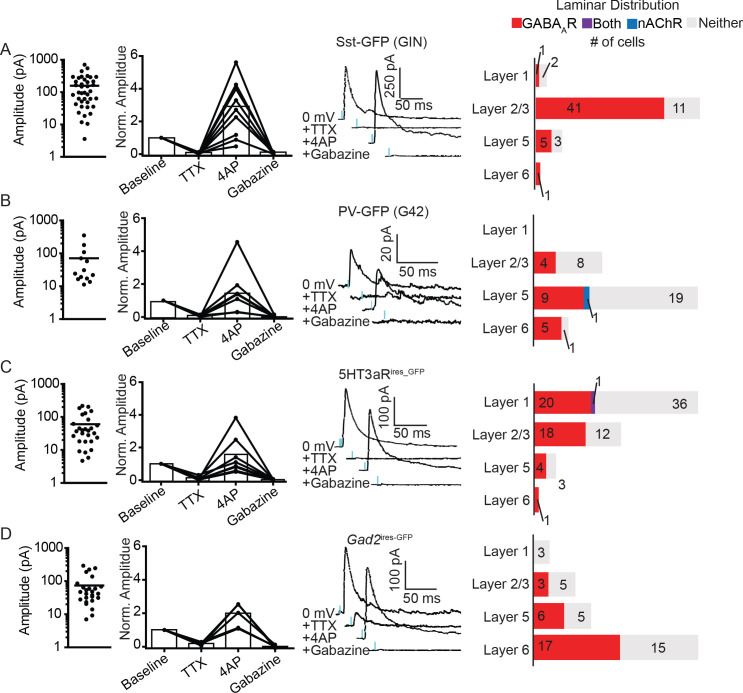
GABAAR-mediated synaptic currents from VIP+/ChAT+ interneurons are mono-synaptic.(A–D). Synaptic response amplitudes, sensitivity to TTX, 4AP, and gabazine, and laminar distribution for GFP-expressing post-synaptic neurons in Sst-GFP (GIN) mice (A), PV-GFP (G42) mice (B), 5HT3aRires-GFP mice (C), and Gad2ires-GFP mice (D). Left: mean response amplitude. Middle left: Quantification of sensitivity to TTX, 4AP, and gabazine. All synaptic responses are blocked by TTX, substantially rescued by 4AP, and completely abolished by gabazine. Middle right: example traces showing synaptic response amplitude following consecutive application of TTX, 4AP, and gabazine. Right: Laminar distribution of recorded neurons. Numbers indicate the number of cells in each category. Total number of neurons and mice are the same as Figure 3.